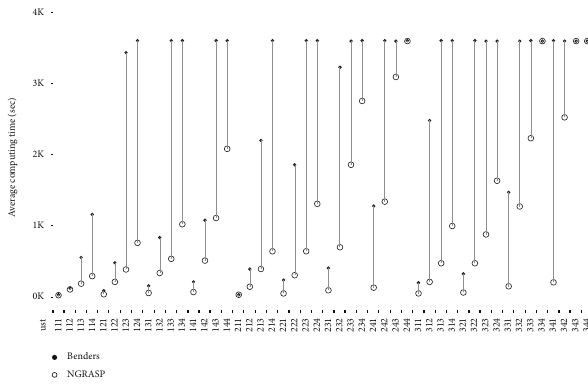
Figure 6: Average computational time on 49-node